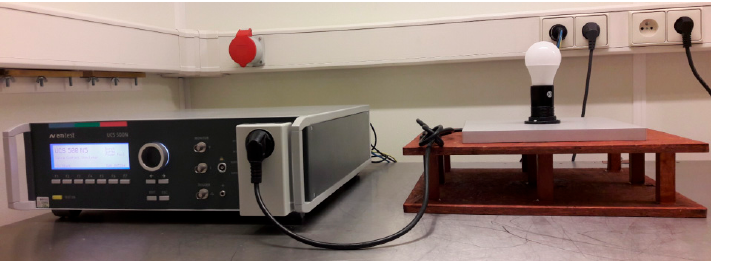
Figure 2. Stand for immunity testing of LED lamps to 1.2/50 µs/(8/20 µs) using the UCS500N5 generator by EMTest. Table 1. Immunity results for lamp A and B on surge impulse 1.2/50 µ s (8/20 µ